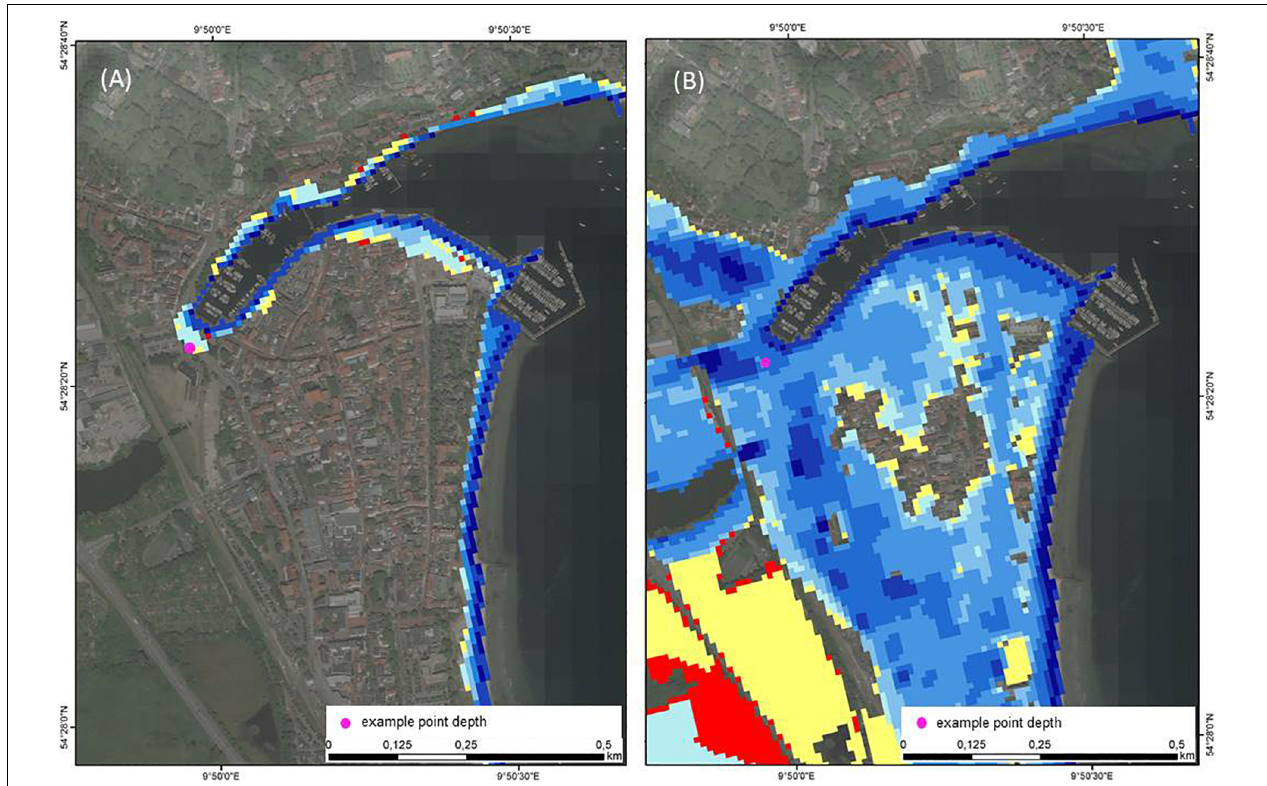
FIGURE 5 | Flood extent simulated with Delft3D for hydrographs with water levels corresponding to a 200-year return period (A) and in combination with 1 m sea-level rise (B) in the city center of Eckernförde.